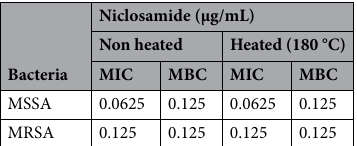
Table 1. MIC and MBC of non-heated NIC, and heated NIC at 180 °C.